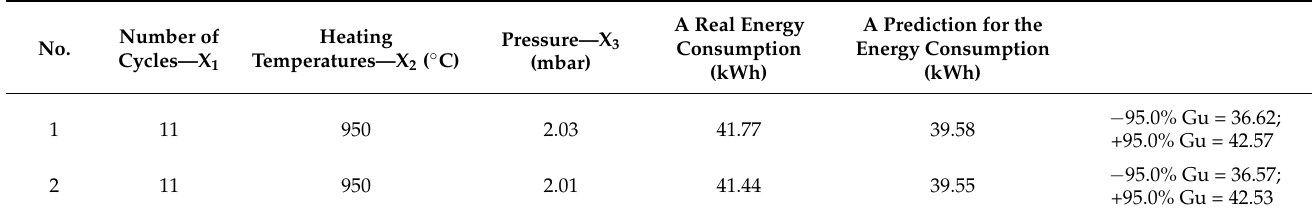
Table 3. Real data of the low-pressure carburising